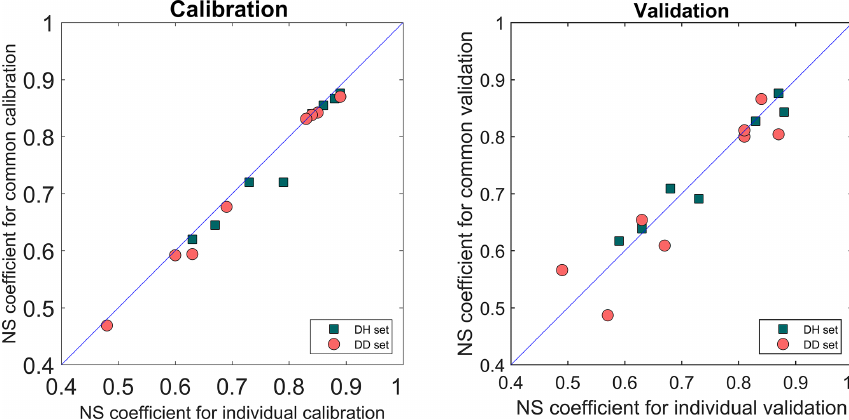
Figure 14. Comparison of the NS coefficient for individual calibration and common calibration using datasets with different temporal